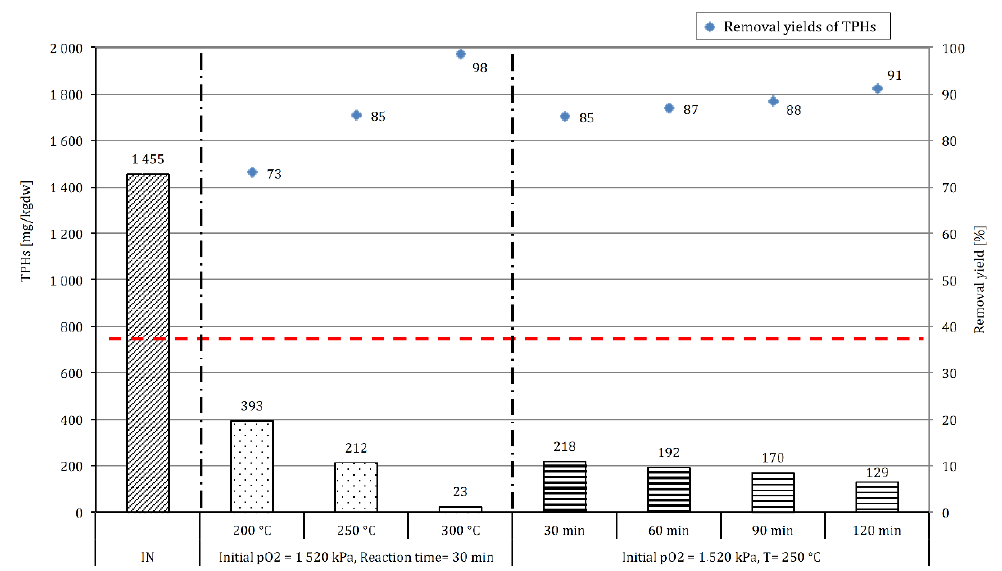
Figure 2. Results obtained for soil #1. Initial pO 2 = initial partial pressure of oxygen fed into the reactor. Dotted line represents the limit (750 mg(TPHs) · kg dw − 1 ) imposed by Italian law for the reuse of the treated soil [36]. TPHs: total petroleum hydrocarbons.